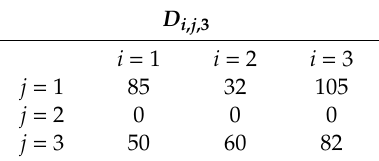
Table A3. Demand at period 3 (units).